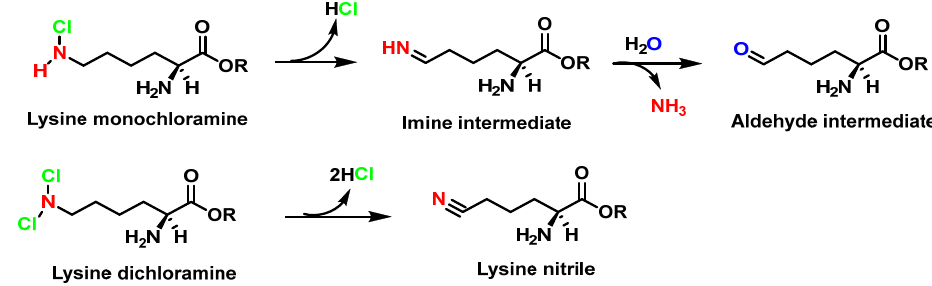
Figure 39. Decomposition of lysine monochloramide with formation of aldehyde and nitrile from dichlorinated Lys.